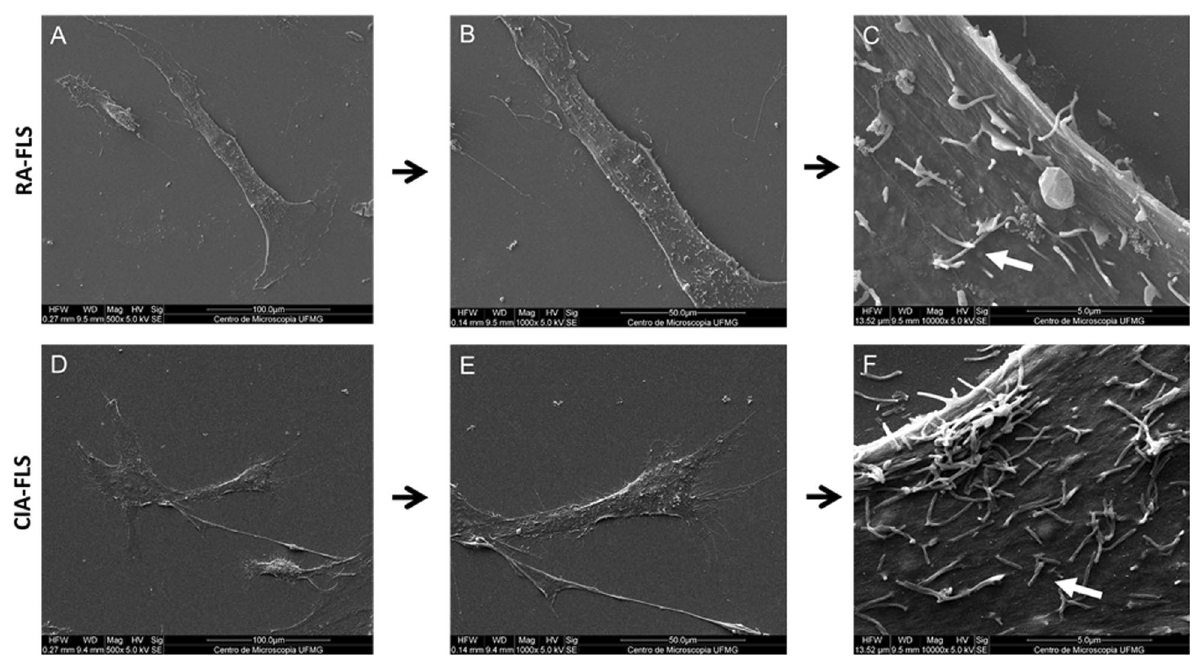
Fig. 2 Fibroblast-like synoviocytes were observed by scanning electron microscopy. A – C Fibroblast-like synoviocytes from patients with rheumatoid arthritis showing cytoplasmic extensions and the presence of filopodia (white arrow). D – F Fibroblast-like synoviocytes from mice with collagen-induced arthritis showing the presence of filopodia (white arrow)